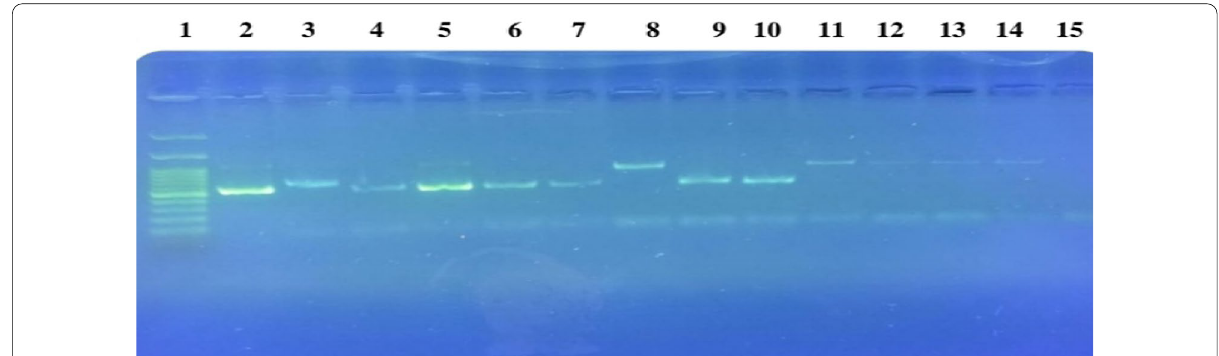
Fig. 3 Red safe stained 1.5% Agarose gel showed PCR products of 14 selected Candida spp. Note : Bands of PCR products of Candida glabrata